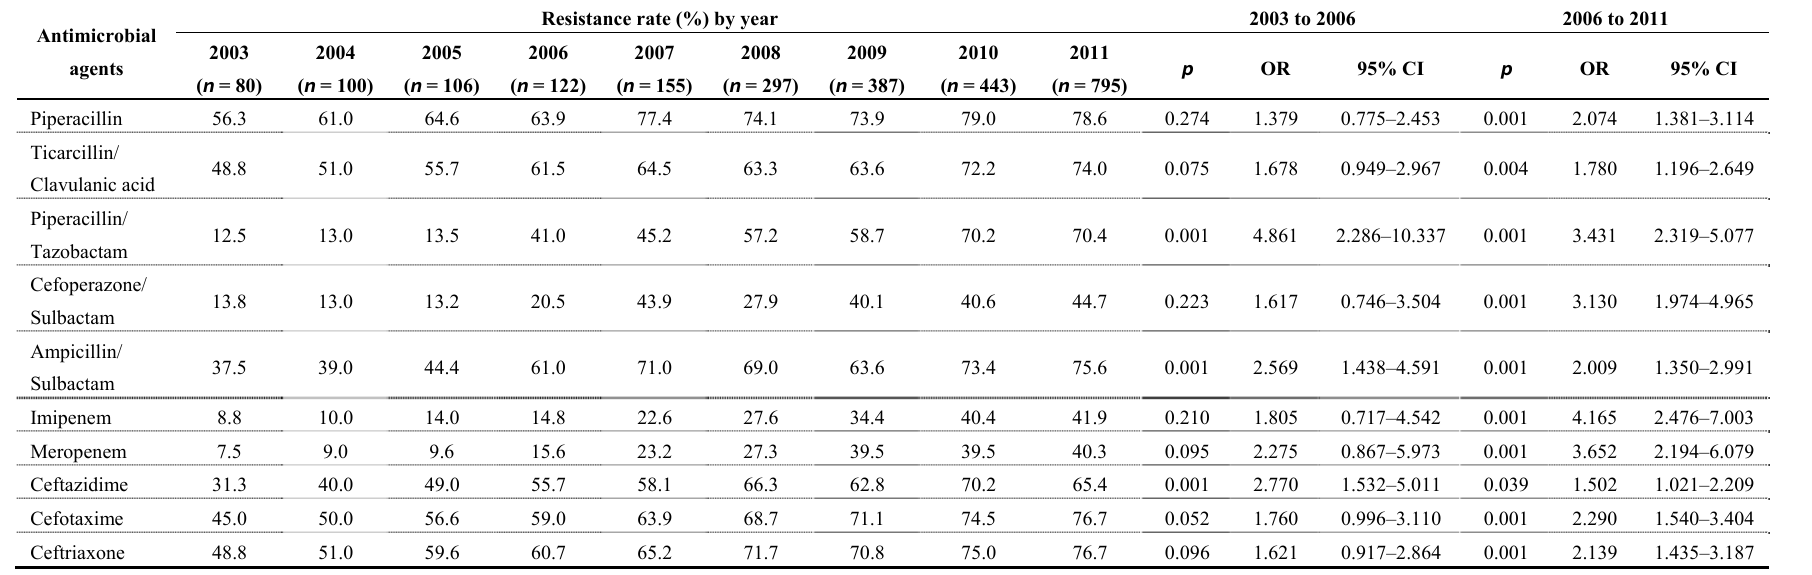
Table 2. Antimicrobial resistance of A. baumannii complex isolated from First Hospital of Jilin University, 2003–2011.